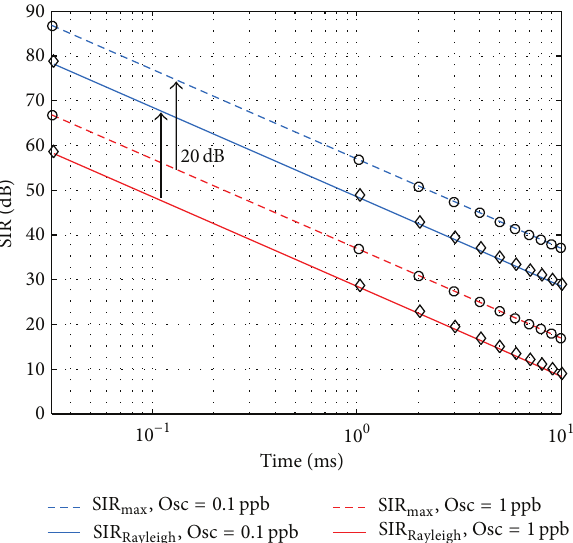
Figure 3: Mean SIR over time for Rayleigh fading channel and SIR upper bound. Here, 7 base stations using oscillators of accuracy given by Osc serve jointly 6 users. Analytical results are shown by lines, simulations by